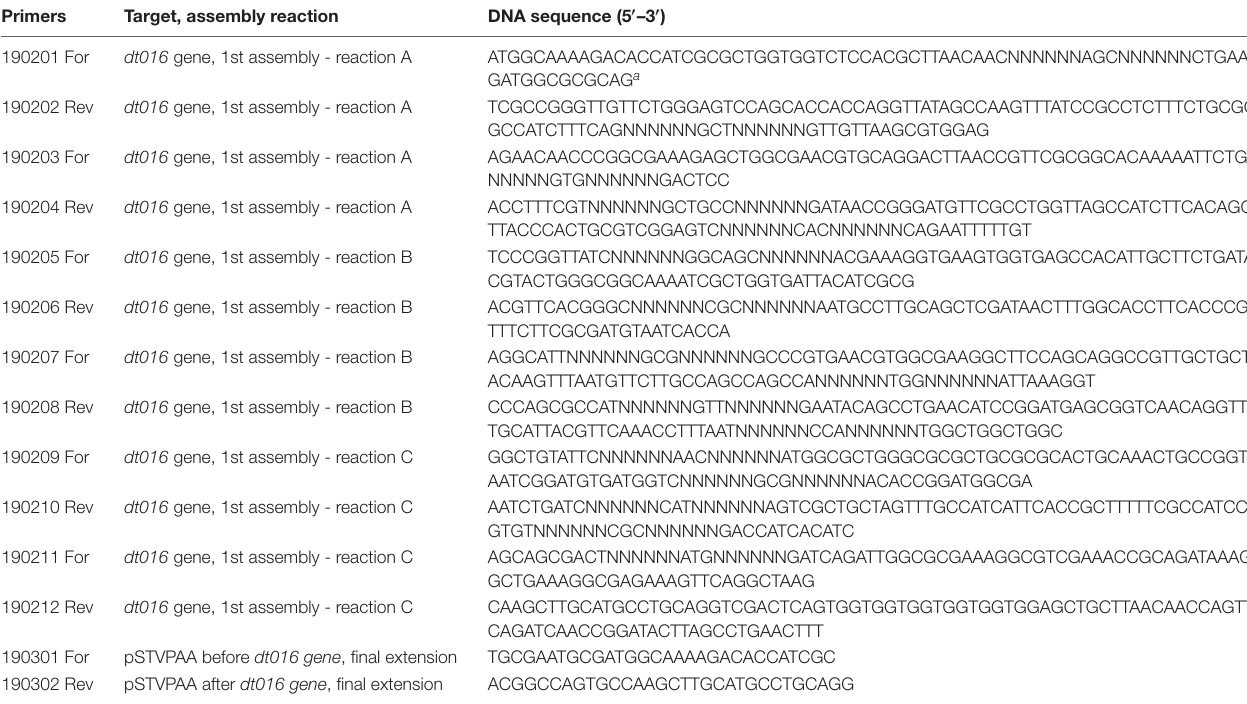
TABLE 5 | List of primers used to introduce new mutations close to pre-existing mutations on DT016